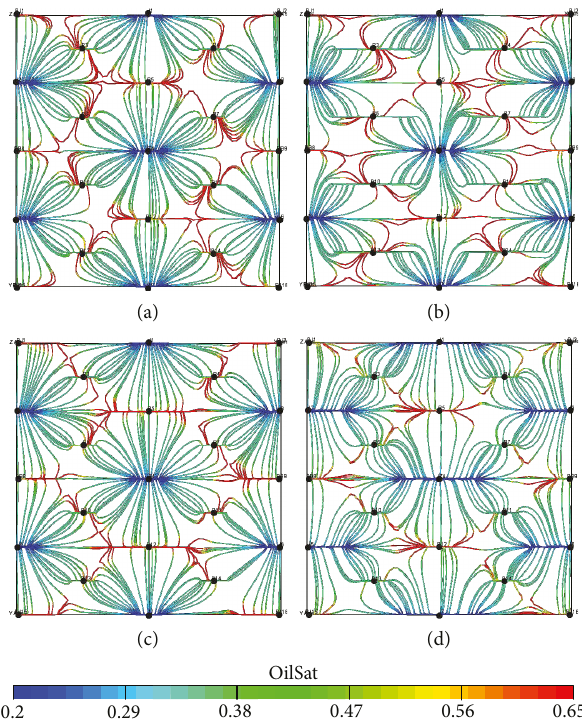
Figure 2: Streamline simulation results corresponding to di ff erent cases in Table 1. (a) Case no. 1. (b) Case no. 2. (c) Case no. 3. (d) Case no. 4.